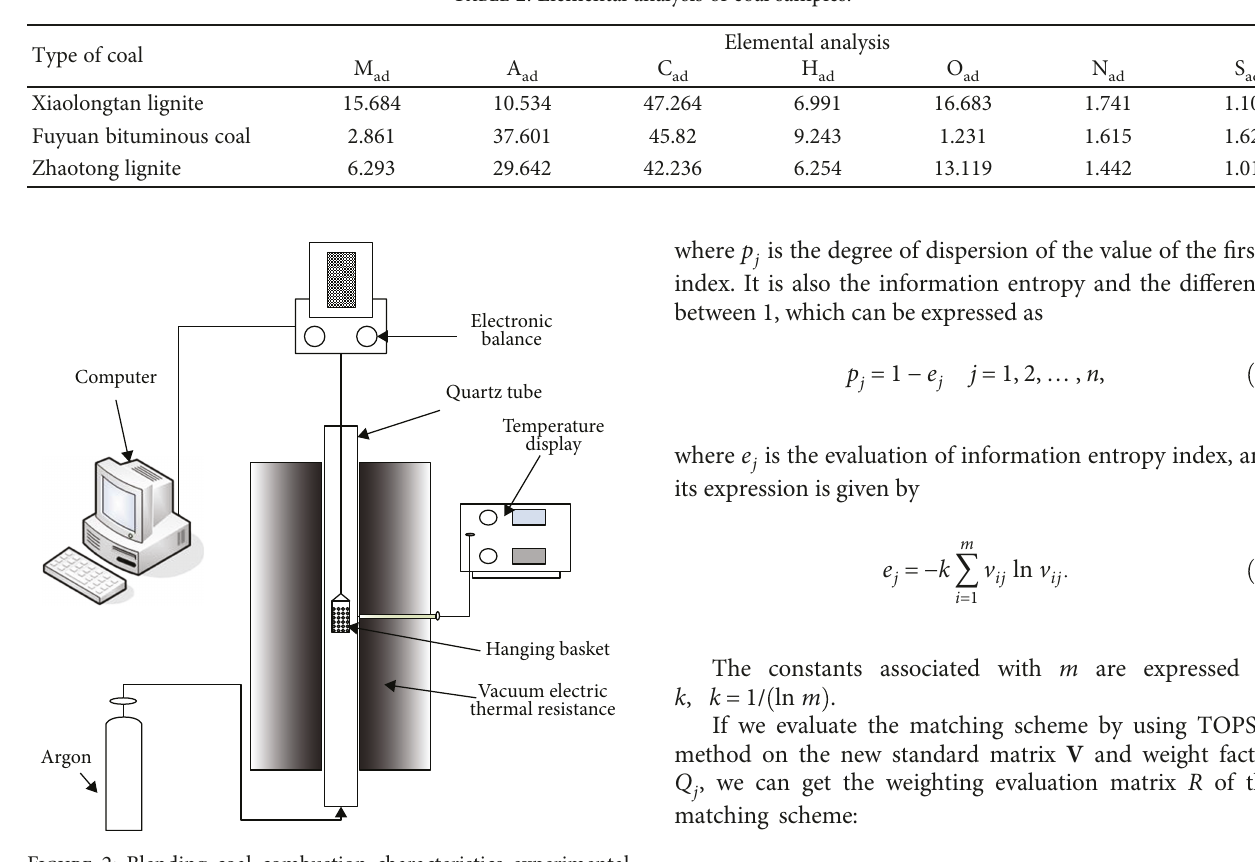
Table 2: Elemental analysis of coal samples.